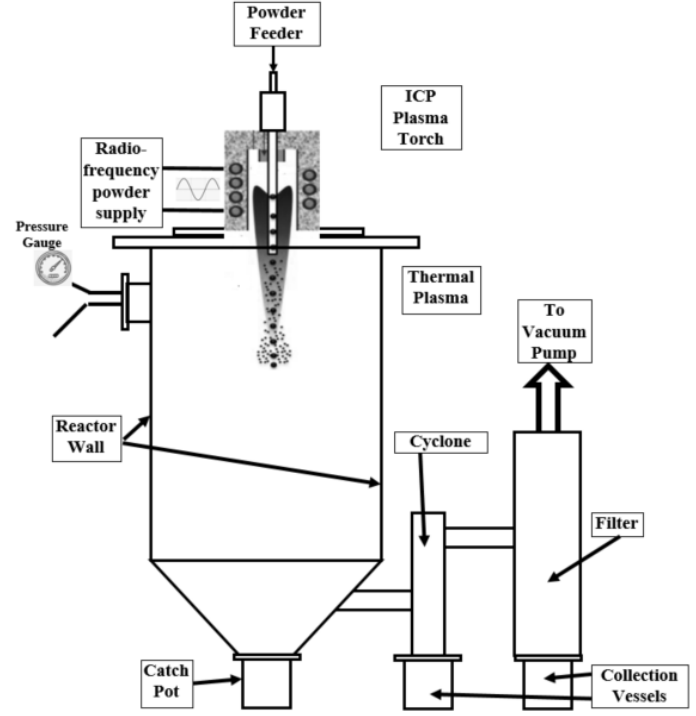
Figure 1. Schematic of the TEKNA 15 kW experimental setup. Table 1. Particle size distribution of the feed powder for the bulk test.